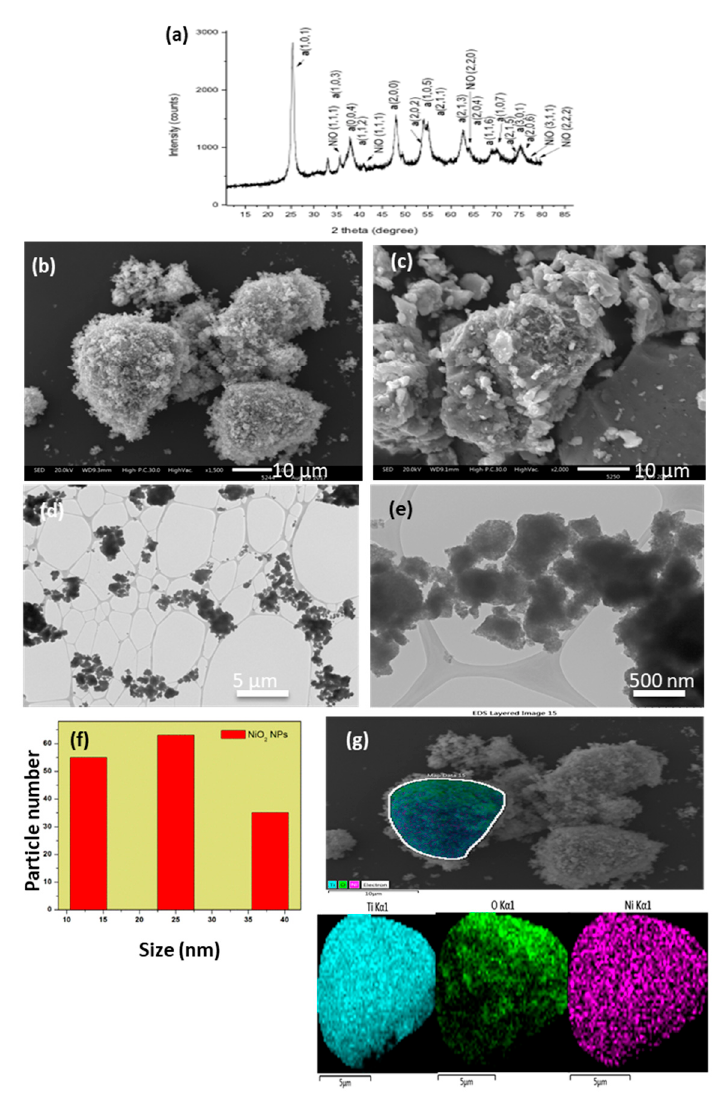
Figure 3. ( a ) XRD pattern; ( b ) SEM image of NiO from chitosan and ( c ) from PVP; ( d , e ) TEM images of NiO from chitosan and ( f ) their histogram; and ( g ) SEM mapping element for NiO from the chitosan precursor.